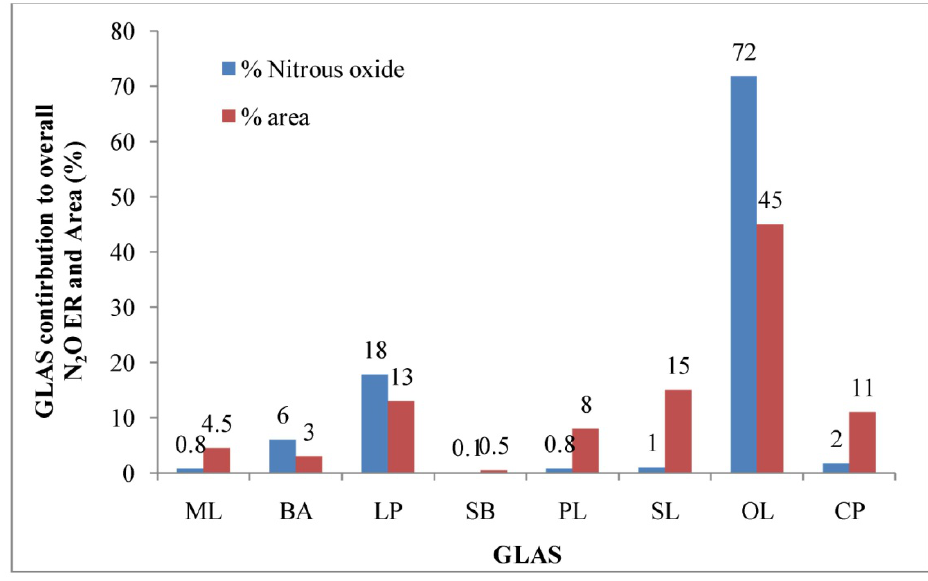
Figure 7. GLAS contribution to overall N O ERs and area at Free-stall dairy during the 2 summer. (Note: ML = manure lane; BA = bedding area; LP = loafing pen; SB = settling basin; PL = primary lagoon; SL = secondary lagoon; OL = open-lot; and CP = compost